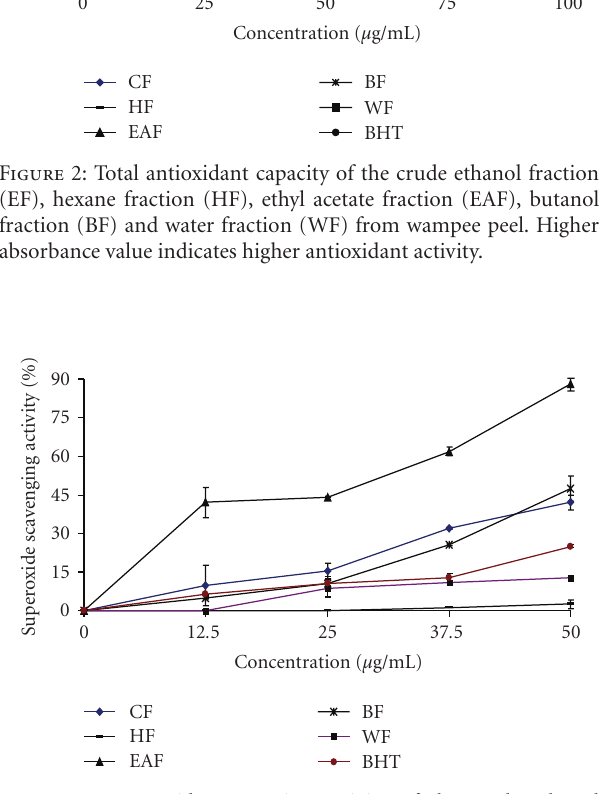
Figure 3: Superoxide scavenging activity of the crude ethanol fraction (EF), hexane fraction (HF), ethyl acetate fraction (EAF), butanol fraction (BF) and water fraction (WF) from wampee peel.